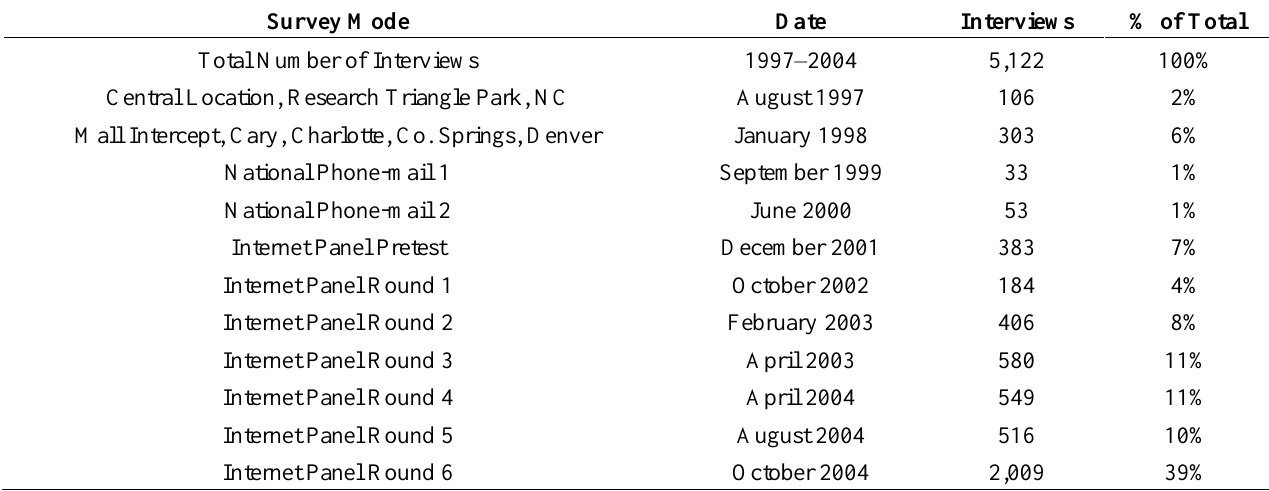
Table 1. Characteristics and timing of the survey